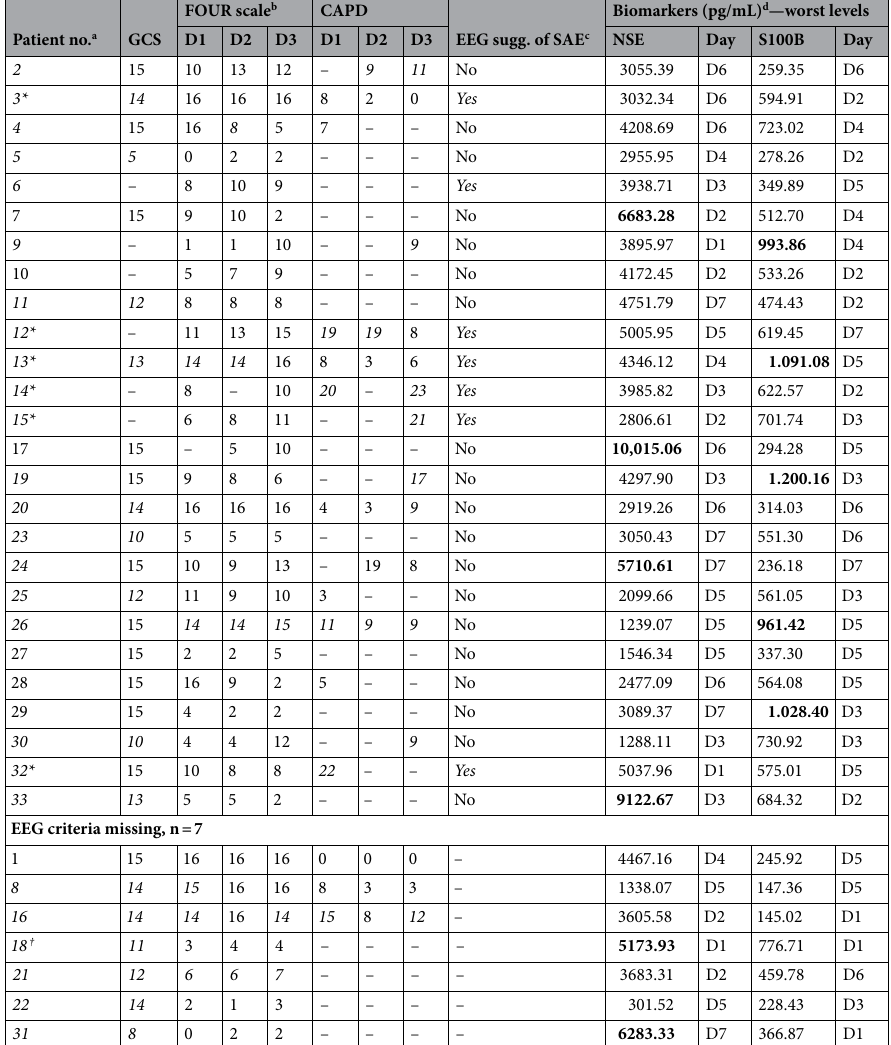
Table 2. Clinical scales and electroencephalographic results used for the presumptive diagnosis of SAE and the worst levels of biomarkers on the days they were detected. SAE septic-associated encephalopathy, GCS Glasgow Coma Scale, FOUR full outline of unresponsiveness scale, D1–D2–D3 Days 1, 2, and 3 of evolution, CAPD Cornell Assessment of Pediatric Delirium, EEG suggestive of SAE electroencephalogram suggestive of septic-associated encephalopathy, NSE neuron specific enolase, S100B S100 calcium-binding protein B. *Patient with clinical and EEG findings suggestive of SAE. †The only deceased patient. a Values in italics represent abnormal results presumptive of sepsis-associated encephalopathy. b Values in italics represent a score disproportionate to the level of sedation used. Please, see Table S3 in Supplementary File 1 for more details. c For EEG changes considered suggestive of SAE (“Yes”), please, see Table 3, and for all EEG results, please consult Table S5 in Supplementary File 1. d Cells in bold represent levels above reference value. Significant values are in